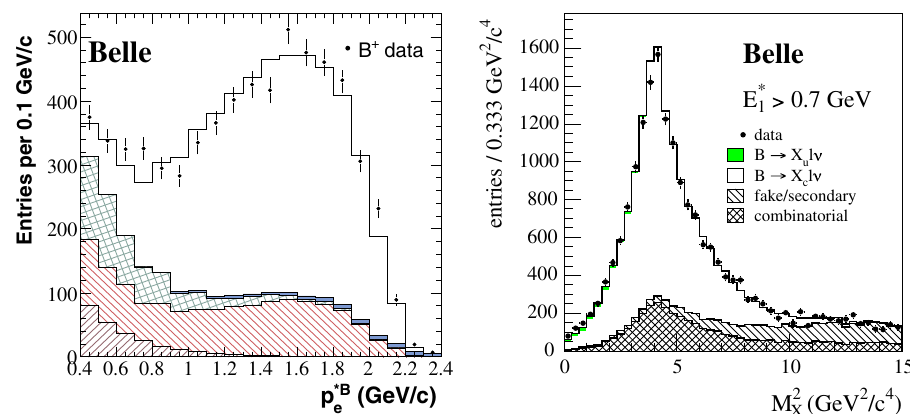
Fig. 7 Belle measurements of the electron energy (left) and hadronic mass (right) spectra